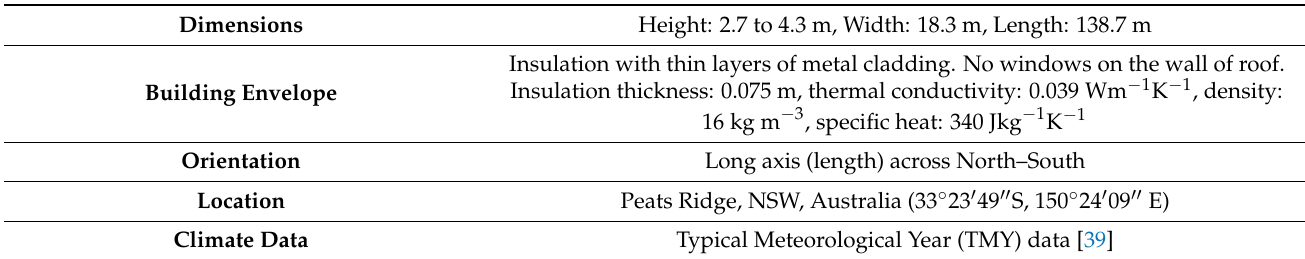
Table 1. Dimensions of a typical broiler house and the location of the temperate climate case study.